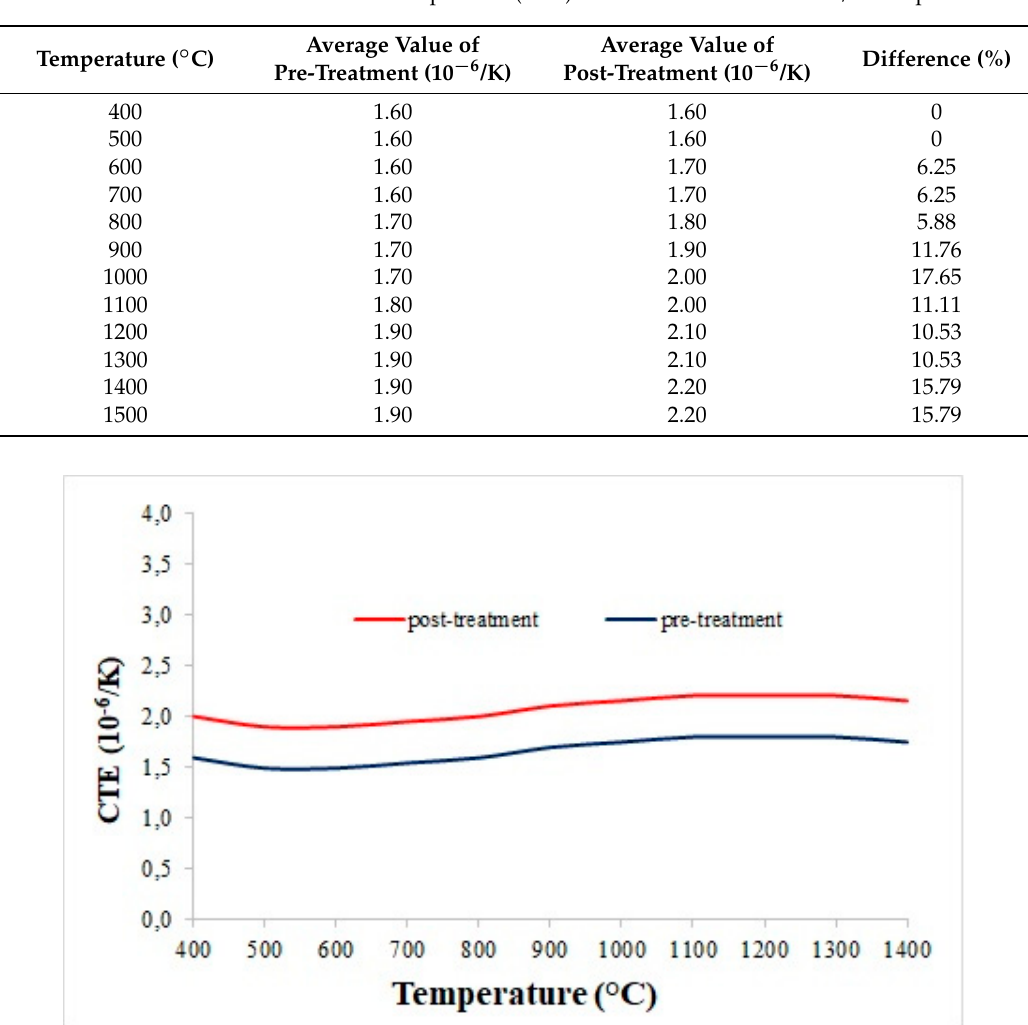
Table 4. The coefficient of thermal expansion (CTE) measurement results for C/C samples.